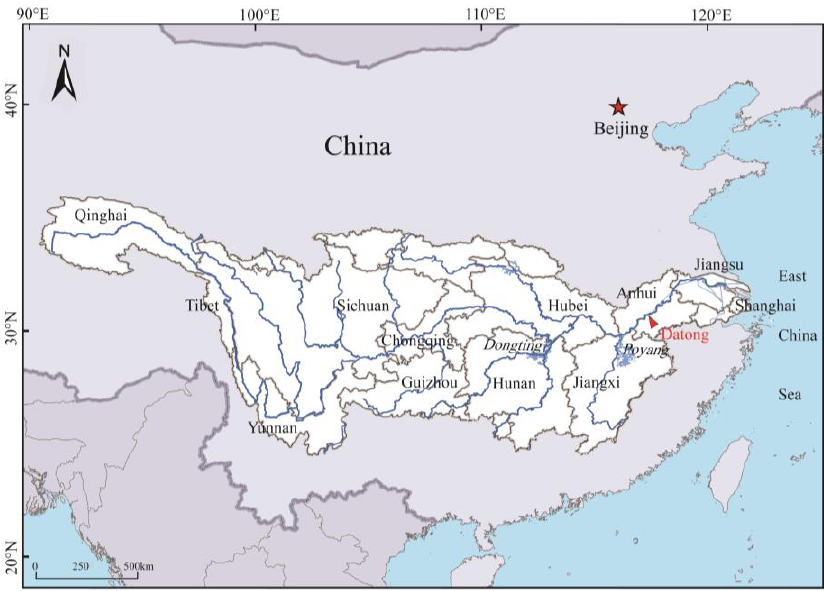
Figure 1. The Yangtze River, its major tributaries, and drainage basin. During the 1980s, the demand for river sand was low and priced at RMB 2–3 per ton. However, it increased to RMB 15 per ton in 2010. Additionally, the demand for sand and gravel increased to 7.6 billion tons within the YRB during 2021